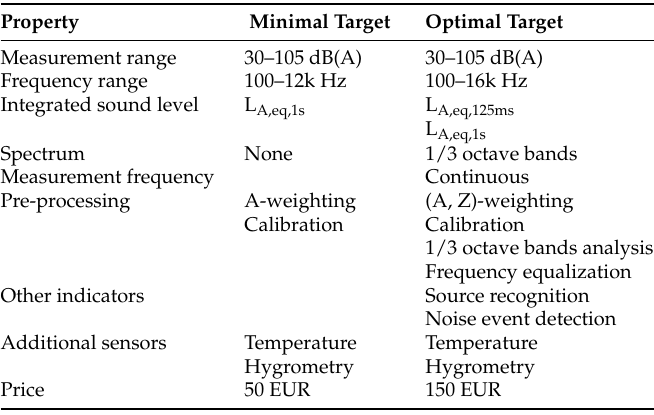
Table 3. Minimal and optimal expected characteristics for the noise